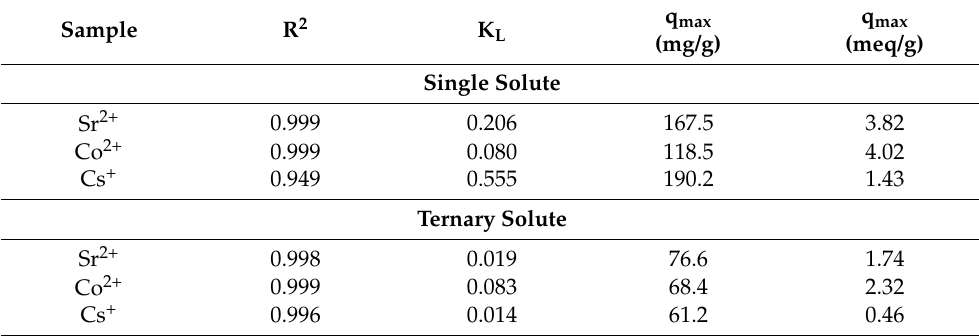
Figure 8. Adsorption isotherm of Sr 2+ , Co 2+ , and Cs + in ( a , c ) single solute and ( b , d ) ternary solute solution. Table 4. Adsorption parameters of Sr 2+ , Co 2+ , and Cs + in single solute and ternary solute solution from the Langmuir isotherm model.